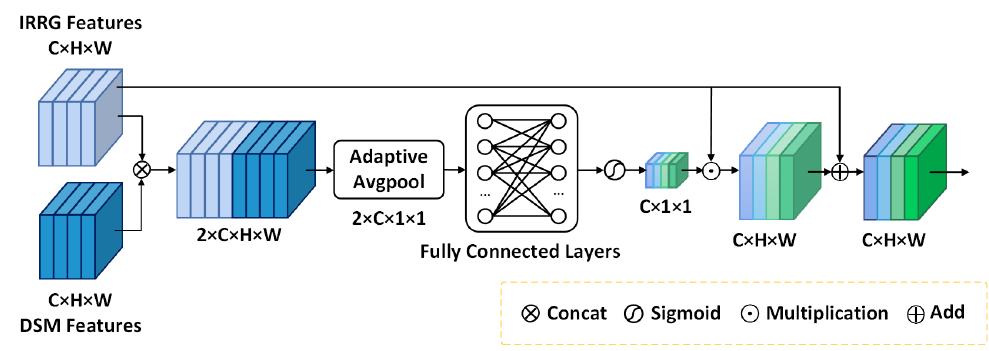
Figure 3. The overview of the selective fusion module (SFM